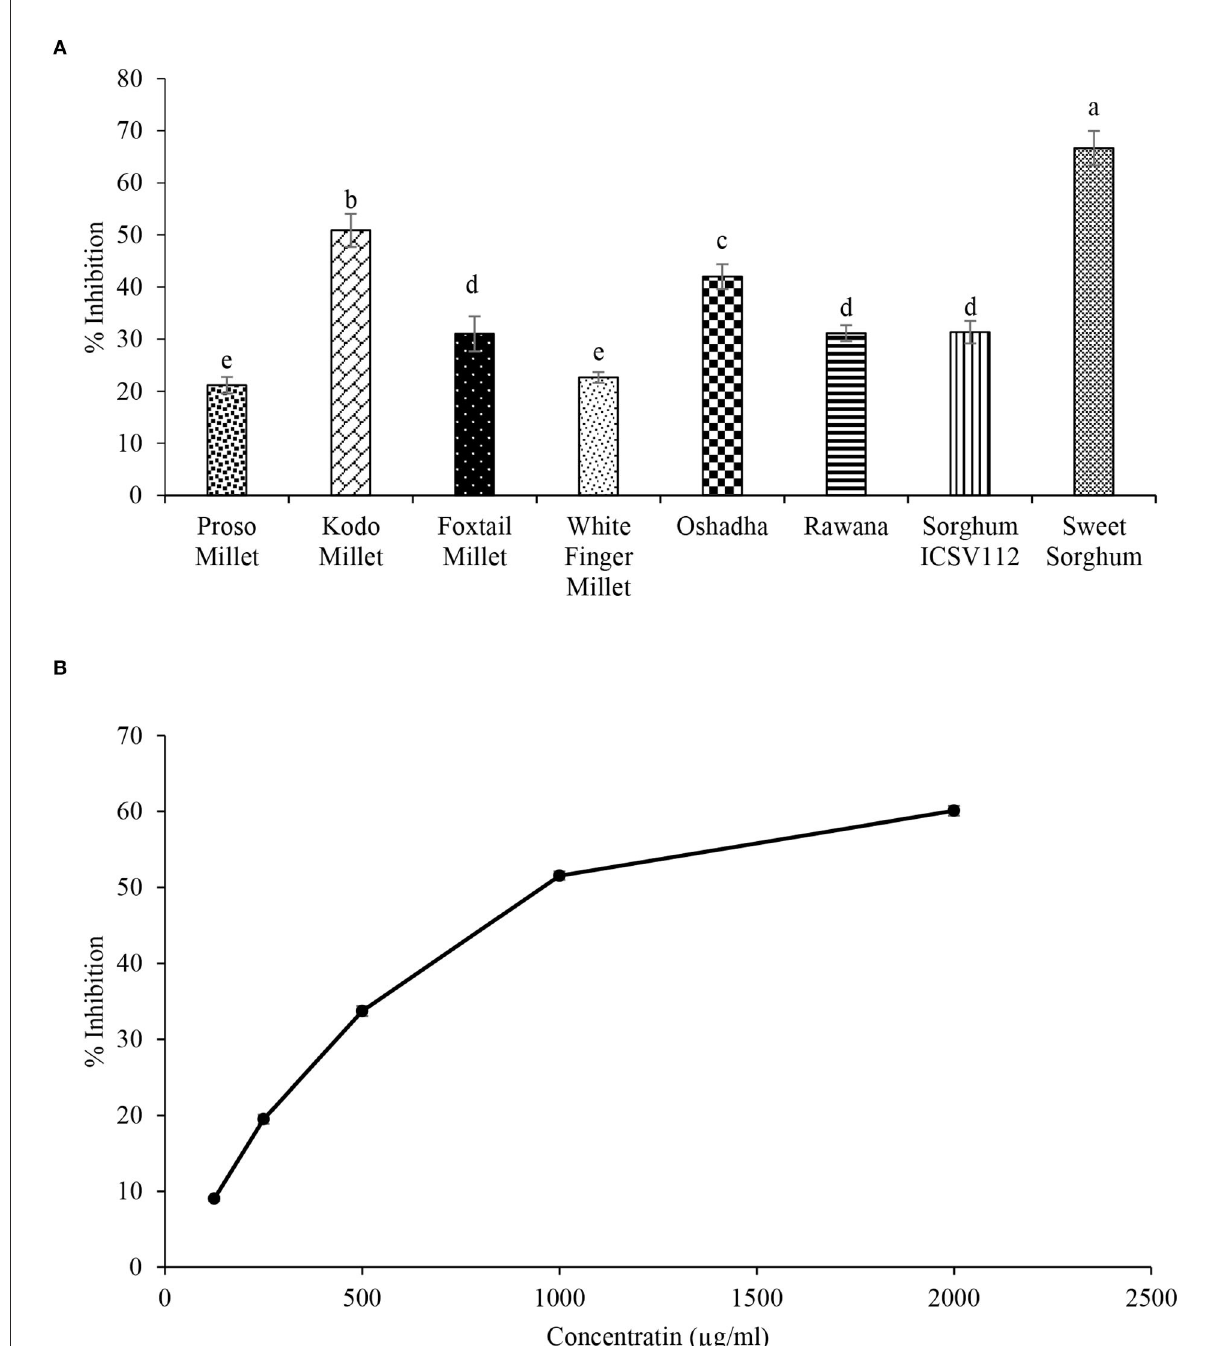
FIGURE2 Lipase inhibitory activity of selected samples. (A) Screening of selected millet types and sorghum varieties for lipase inhibitory activity at 2 mg/ml concentration. (B) Dose-response relationship of sweet sorghum for lipase inhibitory activity: IC 50 : 927.35 ± 5.57 µ g/ml. Different letters on bar graphs are significantly different at P <